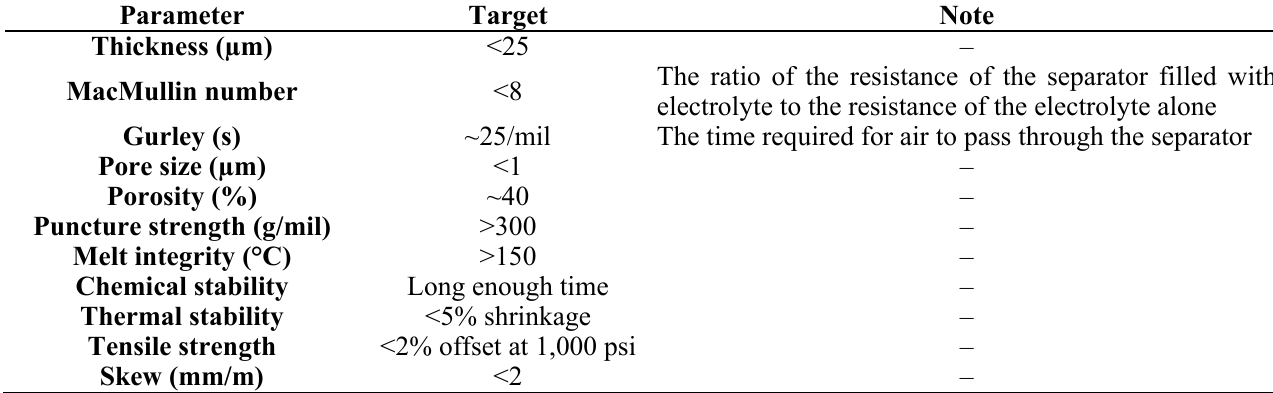
Table 1. Separator requirements for liquid lithium ion batteries (LIBs).